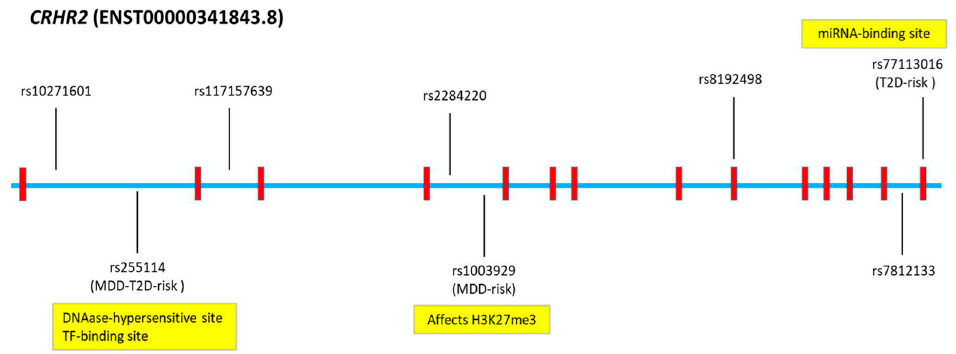
Figure 5. Major Depressive Disorder (MDD) and/or Type 2 Diabetes (T2D) CRHR2 -Single Nucleotide Polymorphisms (SNPs) and In Silico Analysis. In silico functional predictions of CRHR2 -risk variants for MDD and/or T2D.